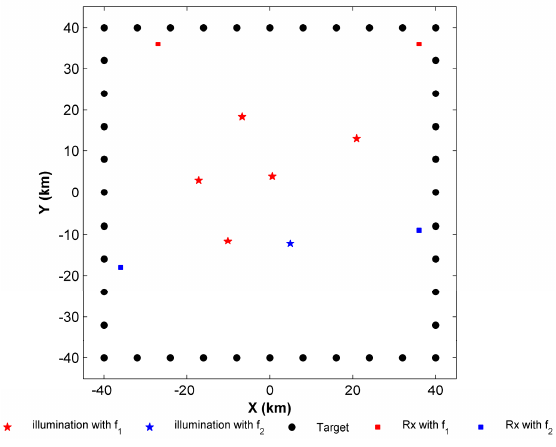
Figure 7. The optimal solution of the PPCP.